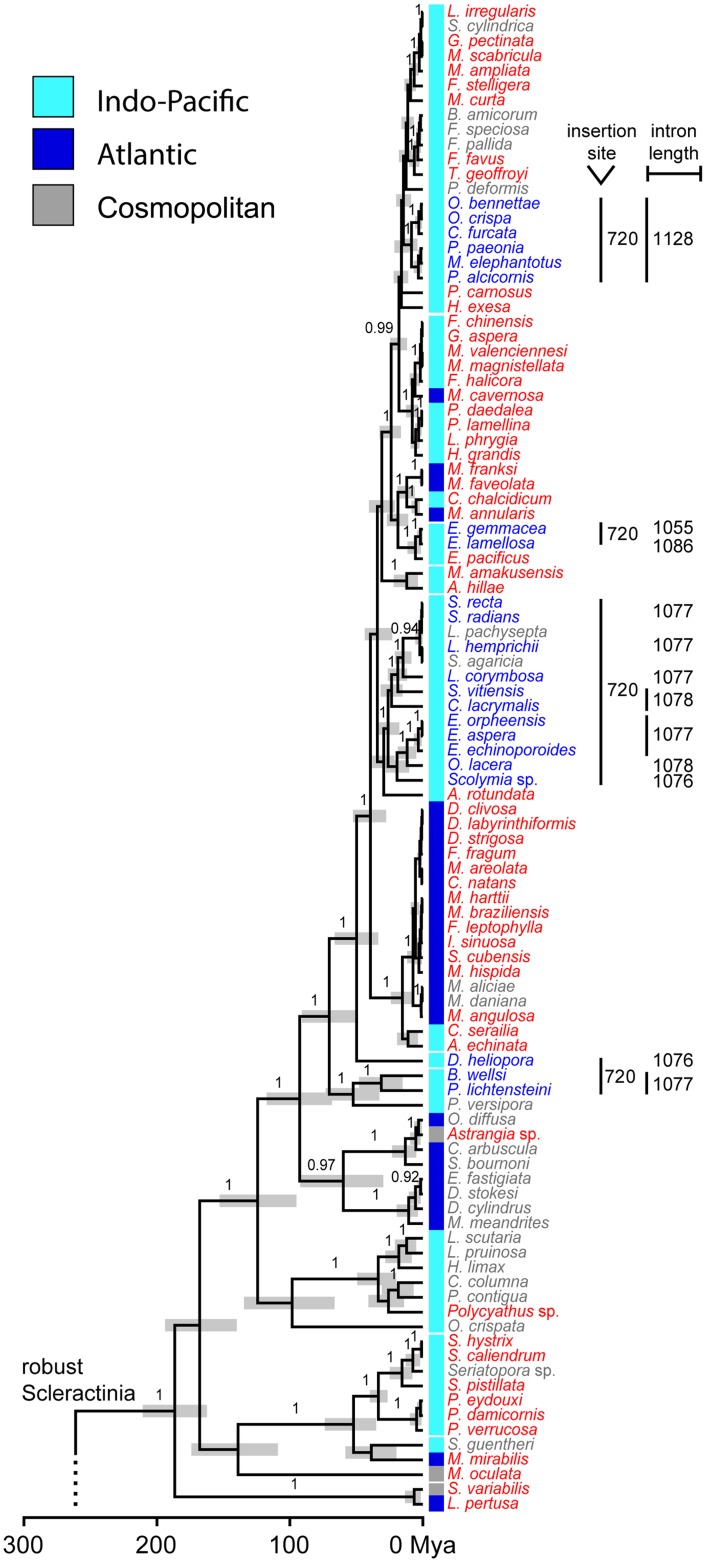
Molecular-clock analysis of robust Scleractinia.A set of eight fossil calibration points was used as suggested by Simpson et al. [53]. Posterior probabilities are placed on branches. Bars in nodes indicate 95% credibility intervals. Taxa are color-coded according to the absence (red) or presence (blue) of an intron or whether no information is available (gray).